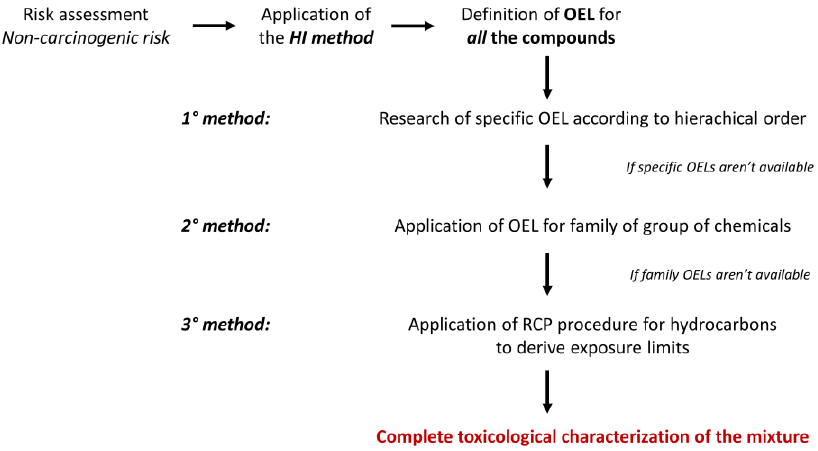
Figure 1. Diagram of OEL definition proposed to obtain the complete toxicological Figure 1. D iagram of OEL definition proposed to obtain the complete toxicological characteriza- tion.